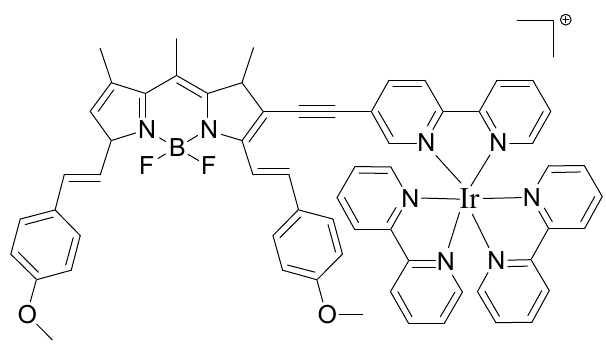
Figure 28. Structure of cyclometalated Ir(III) complex.